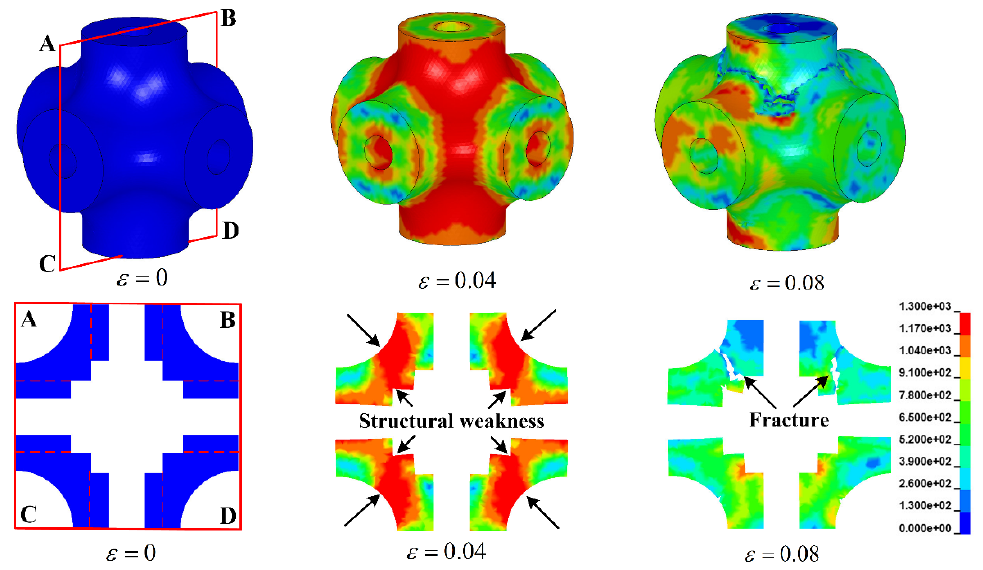
Figure 7. Stress distribution and deformation evolution of unit cell for specimen HTSW.